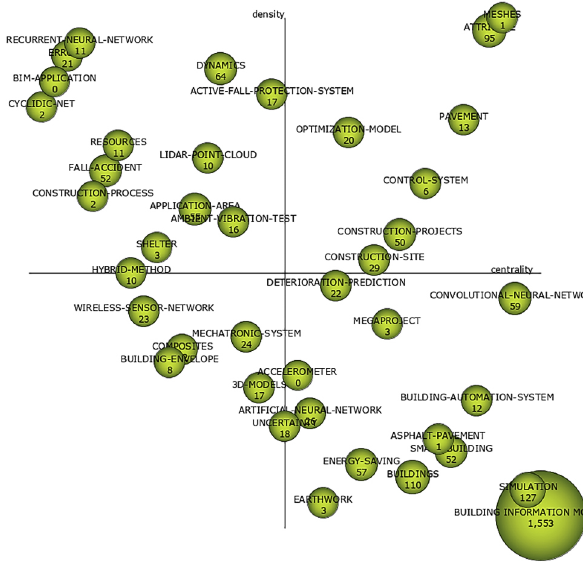
Figure 9. The strategic diagram of the sub-period 2015–2019